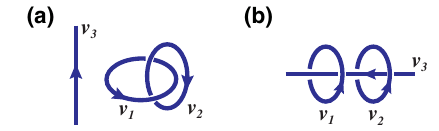
FIG. 17. (a),(b) Two different configurations of chiral vortex